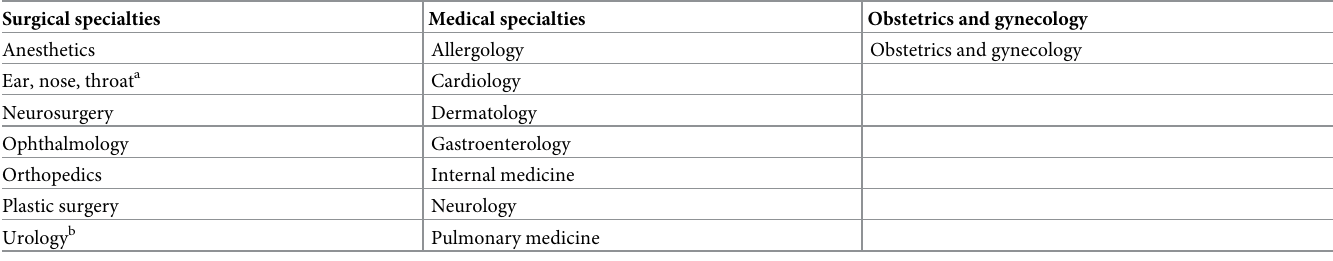
Table 1. Categorization of medical